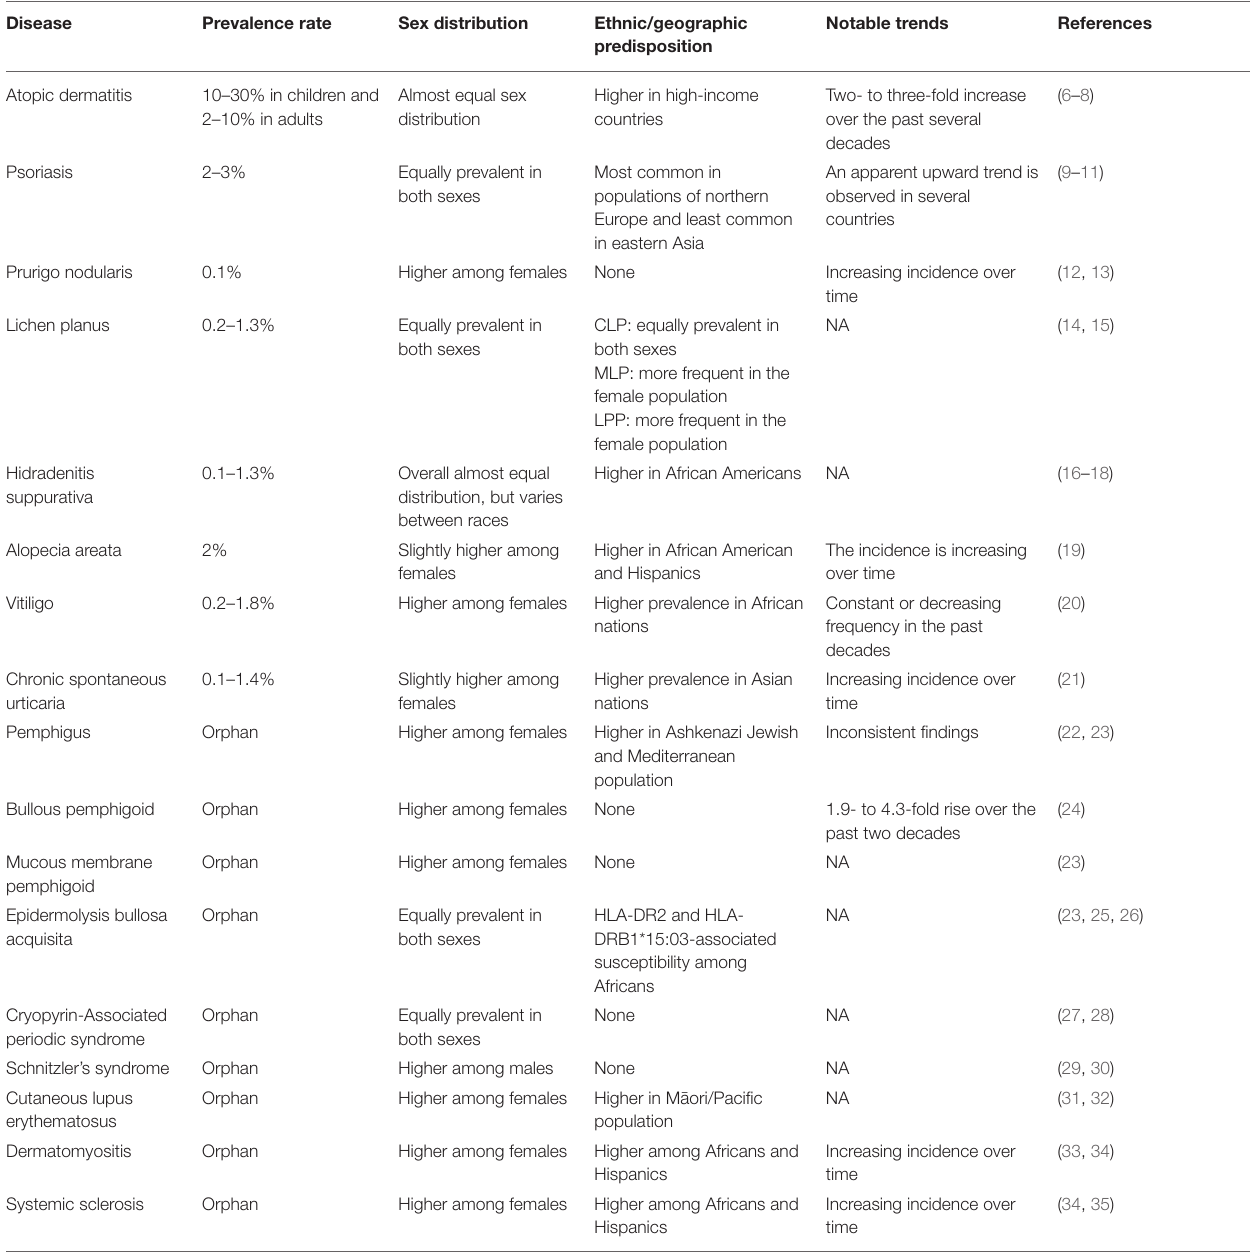
TABLE 1 | Epidemiology of selected chronic inflammatory skin